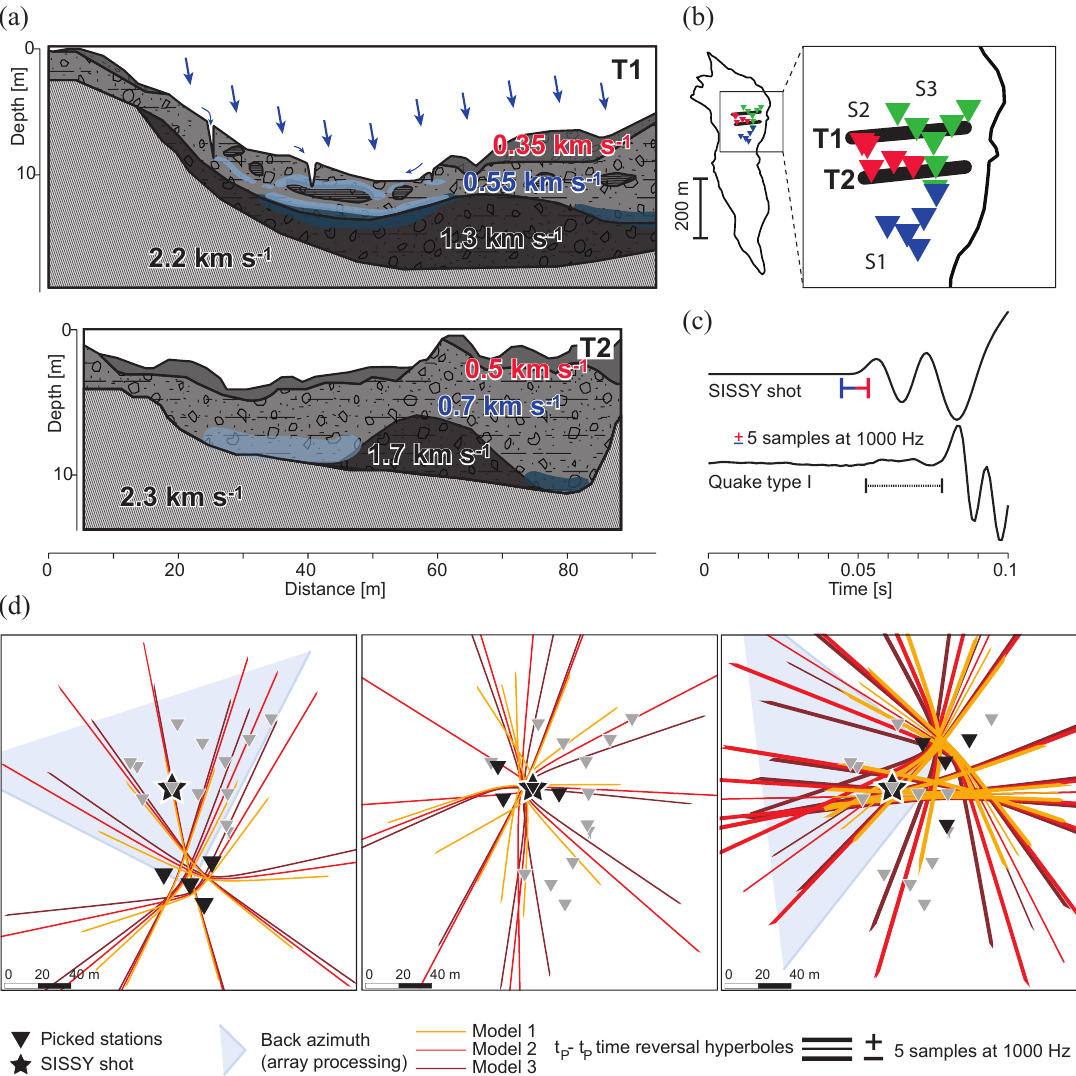
Figure 10. Parameters impacting arrival-time based location uncertainties at clayey landslides. (a) Complex seismic velocity structures along two tomographic profiles T1 and T2 at Super-Sauze (modified from Tonnellier et al. (2013) and Gance et al. (2016)). (b) Location of the tomographic profiles T1 and T2 within the seismic arrays S1, S2 and S3. (c) High-quality first arrival of a SISSY calibration shot (top trace, SZ10, S2.2, t 0 4 June 2010, 11:56:22) and first arrival of a high-SNR quake type I event (bottom trace, SZ10, 29 May 2010, 23:05:03). Note the higher uncertainties about the onset of the natural event. (d) Graphical location solutions for the SZ10 SISSY calibration shot at station S2.1, 4 June 2010, 11:56:22 derived from first arrivals at individual seismic array S1 (left panel), S2 (middle panel) and S3 inner ring (right panel). Picked stations are indicated by black triangles, beam-processing results are symbolized by shaded light-blue quadrants, time-reversal hyperboles derived with three different velocity models (Table 2) are represented by orange, red and brown lines. In the right panel, bold hyperboles display the effect of ± 5 samples’ uncertainties offset shifts in first arrivals. Discussion is found in Sect.